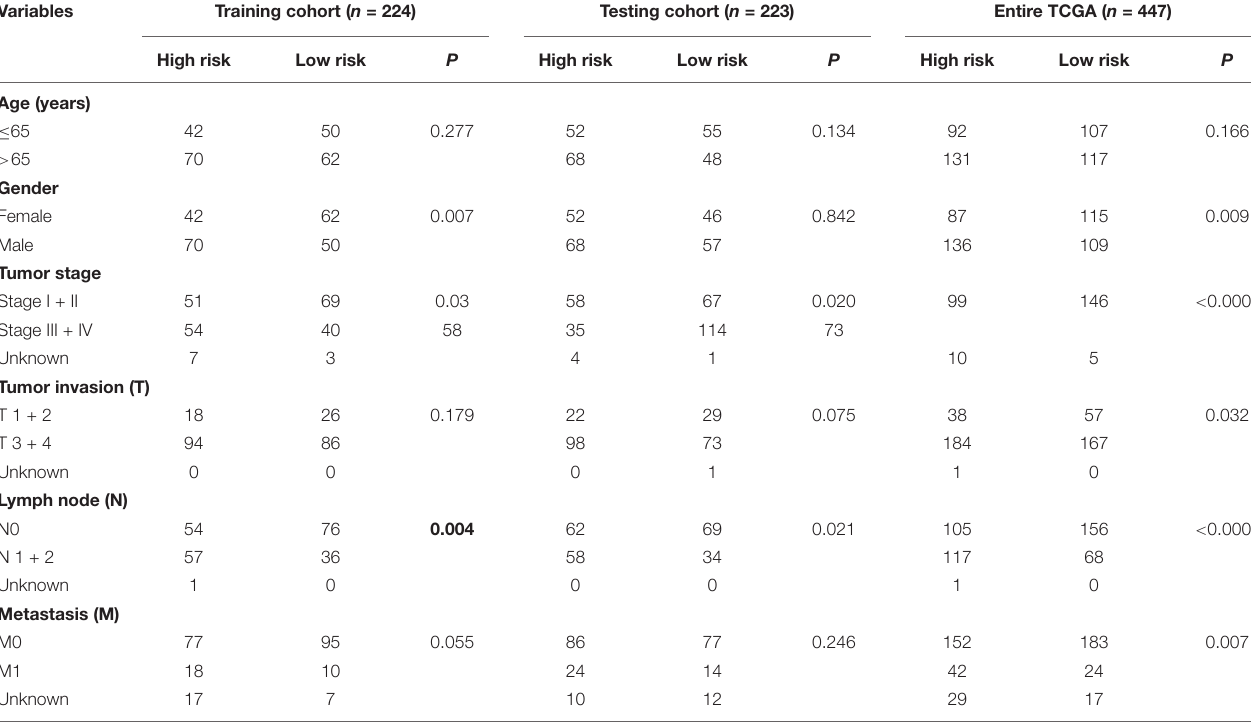
TABLE 3 | Correlation between clinicopathologic characteristics and the immune-related lncRNA signature in colon cancer.